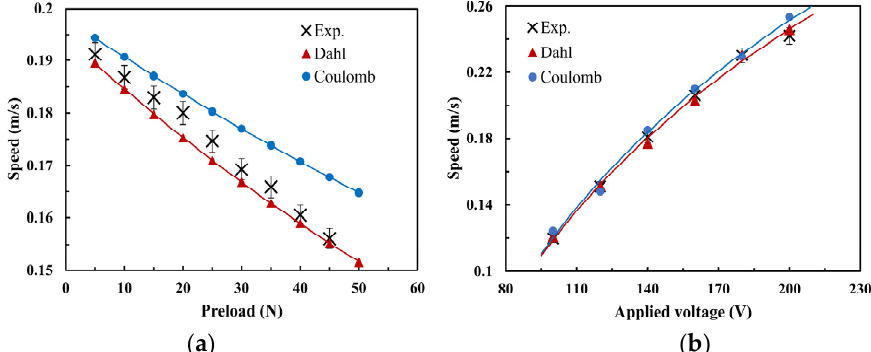
Figure 13. Comparison illustration of no-load theoretic and experimental speeds of the ultrasonic motor under different working conditions: ( a ) preload and ( b ) applied voltage.